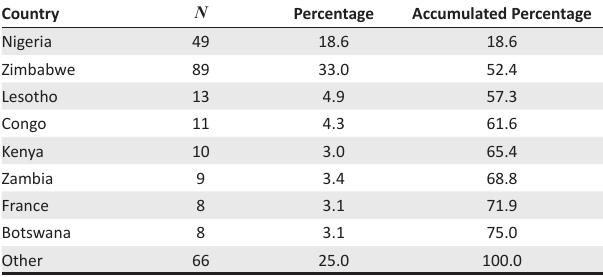
TABLE 2: Country of